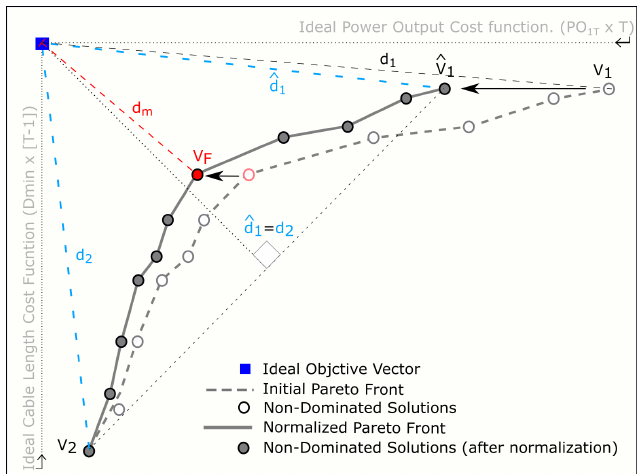
Figure 2. Scheme of the computation of V F